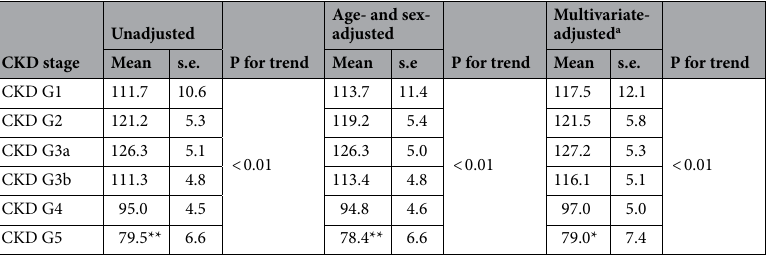
Table 3. Association between CKD stage and the quantity of green leafy vegetables consumed per day. CKD, chronic kidney disease; s.e., standard error. **P < 0.01 vs mean value of CKD G1, *P < 0.05 vs mean value of CKD G1. a Adjusted for age, sex, diabetes, history of cardiovascular disease, systolic blood pressure, body mass